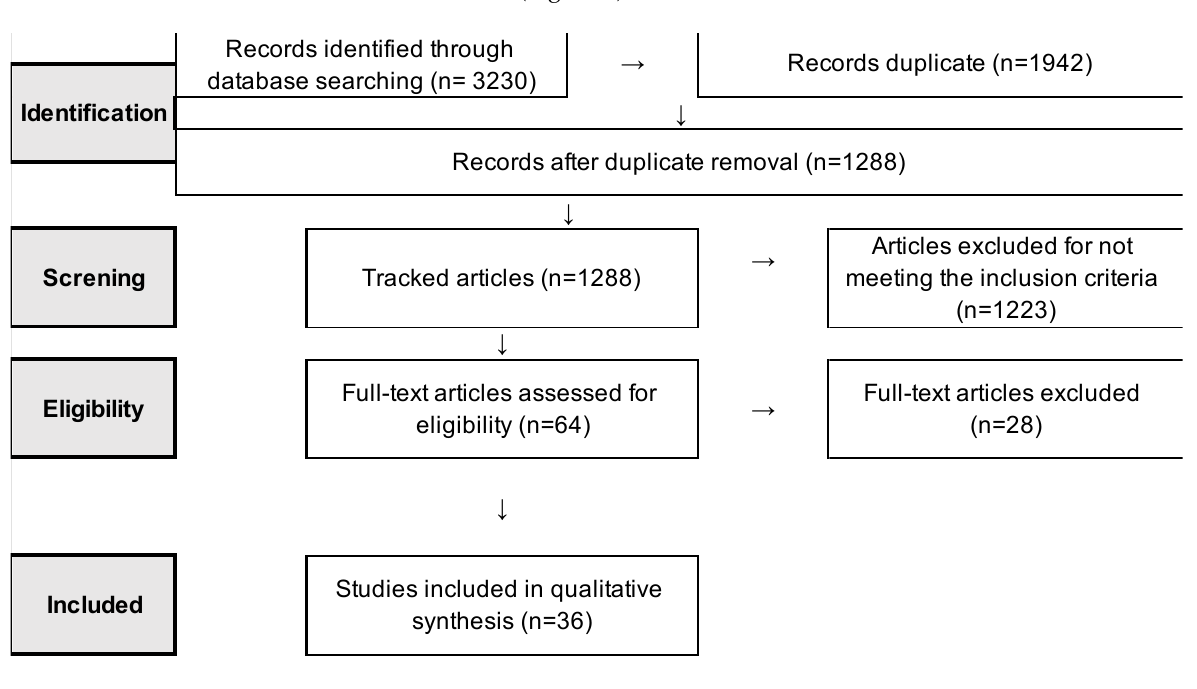
Figure 1. Search and selection process according to PRISMA statement.